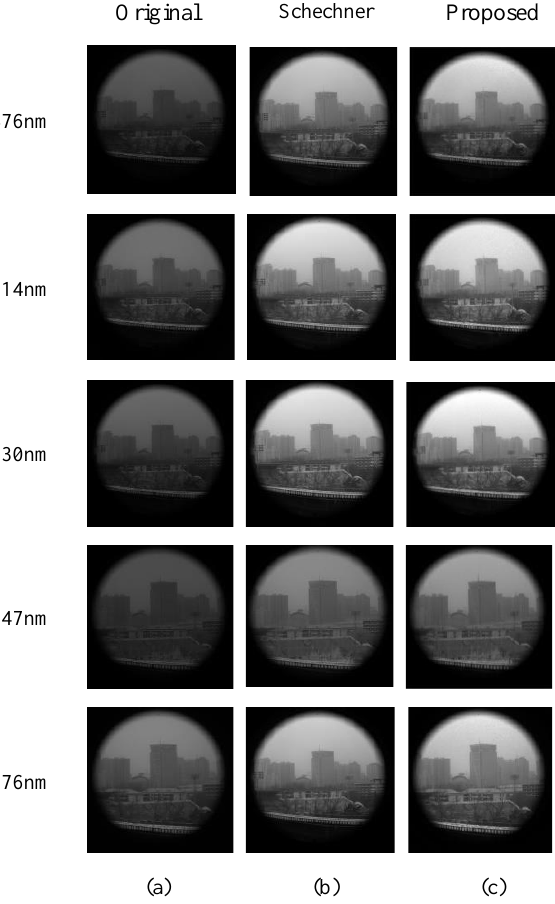
Figure 4. dehazed results using five spectral bands. (a) the first image of four different original polarimetric images, (b) Schechner’s dehazed method, (c)the proposed dehazing